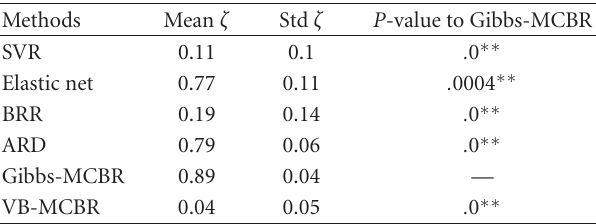
Table 1: Simulated regression data . Explained variance ζ for di ff erent methods (average of 15 di ff erent trials). The P- values are computed using a paired t